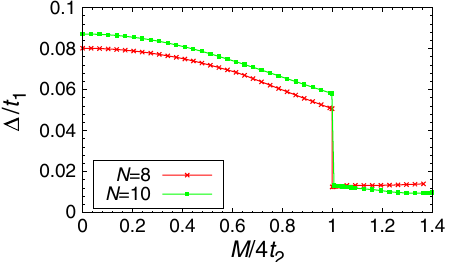
FIG. 15. Energy gap (cid:2) as a function of M at filling (cid:1) ¼ 1 = 3 for N ¼ 8 and N ¼ 10 with N x ¼ N= 2 , N y ¼ 6 . For both system sizes, the transition occurs at M ¼ 4 t 2